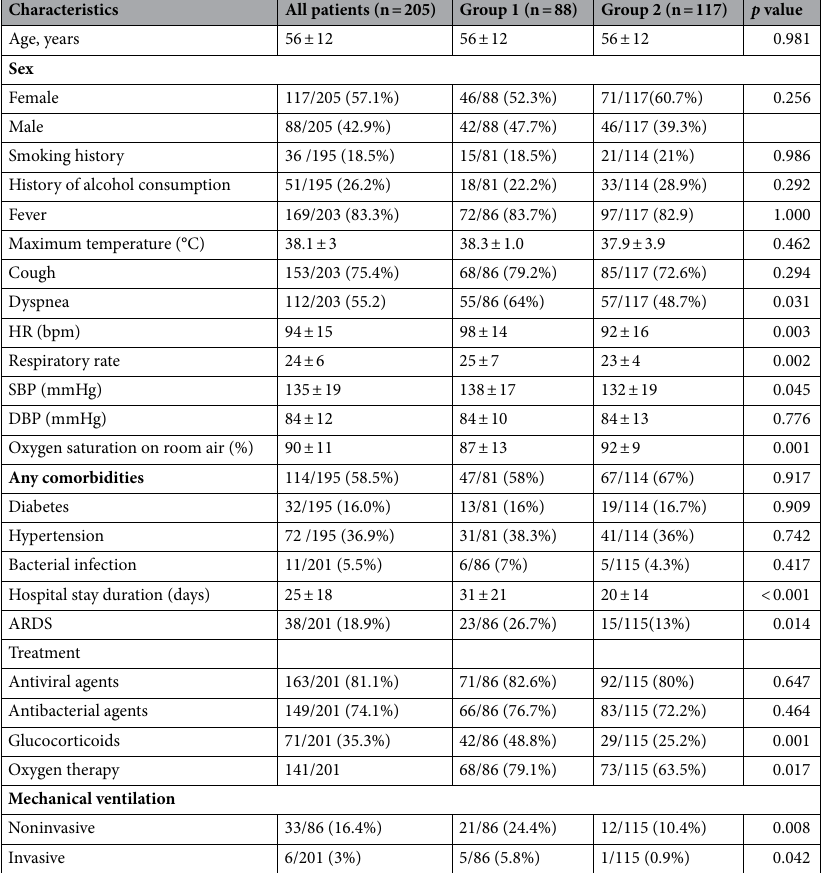
Table 1. Comparison of demographics and clinical characteristics between groups. The data are presented as the means ± SD, medians (interquartile ranges) or n/N (%). p values comparing patients with DL CO < 80%(group 1) and patients with DL CO ≥ 80% (group 2) are from χ 2 , Fisher’s exact test, independent- samples T test or Mann–Whitney U test. HR heart rate, SBP systolic blood pressure, DBP diastolic blood pressure, ARDS acute respiratory distress